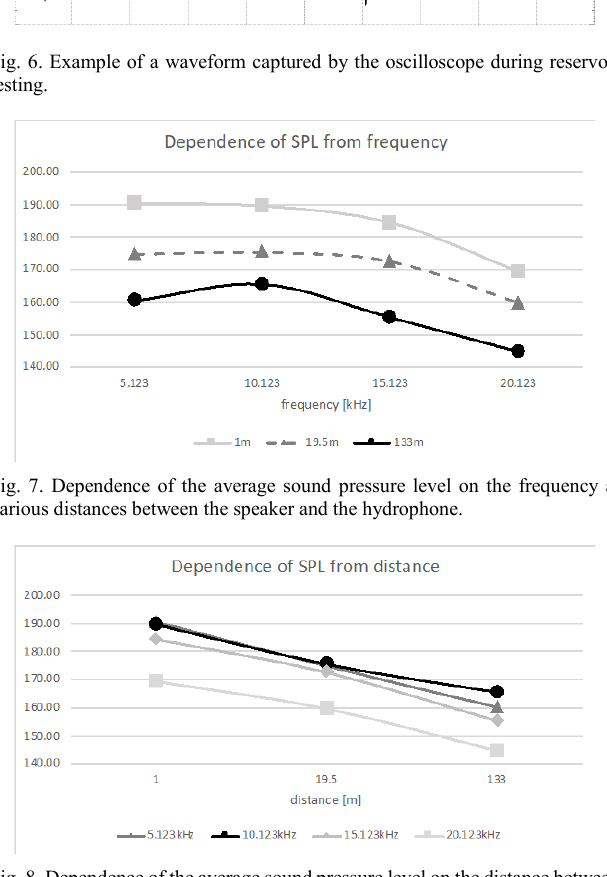
Fig. 8. Dependence of the average sound pressure level on the distance between the speaker and the